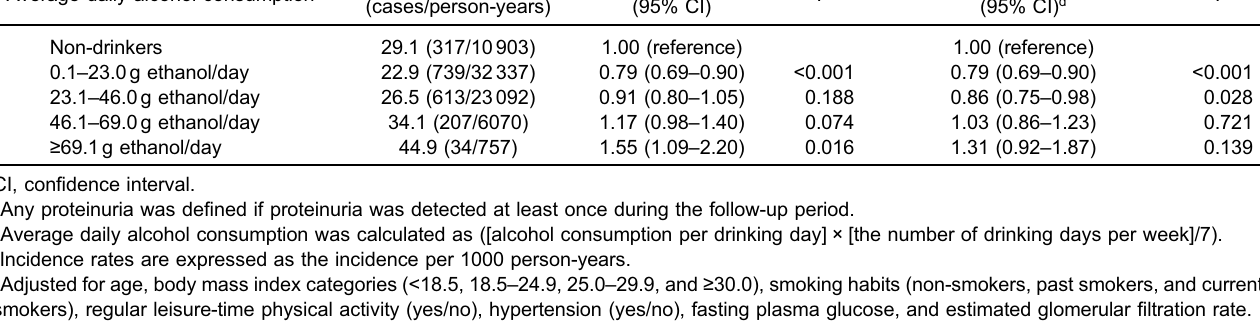
Table 2. Incidence rates and hazard ratios for any proteinuria a according to average daily alcohol consumption Average daily alcohol consumption b